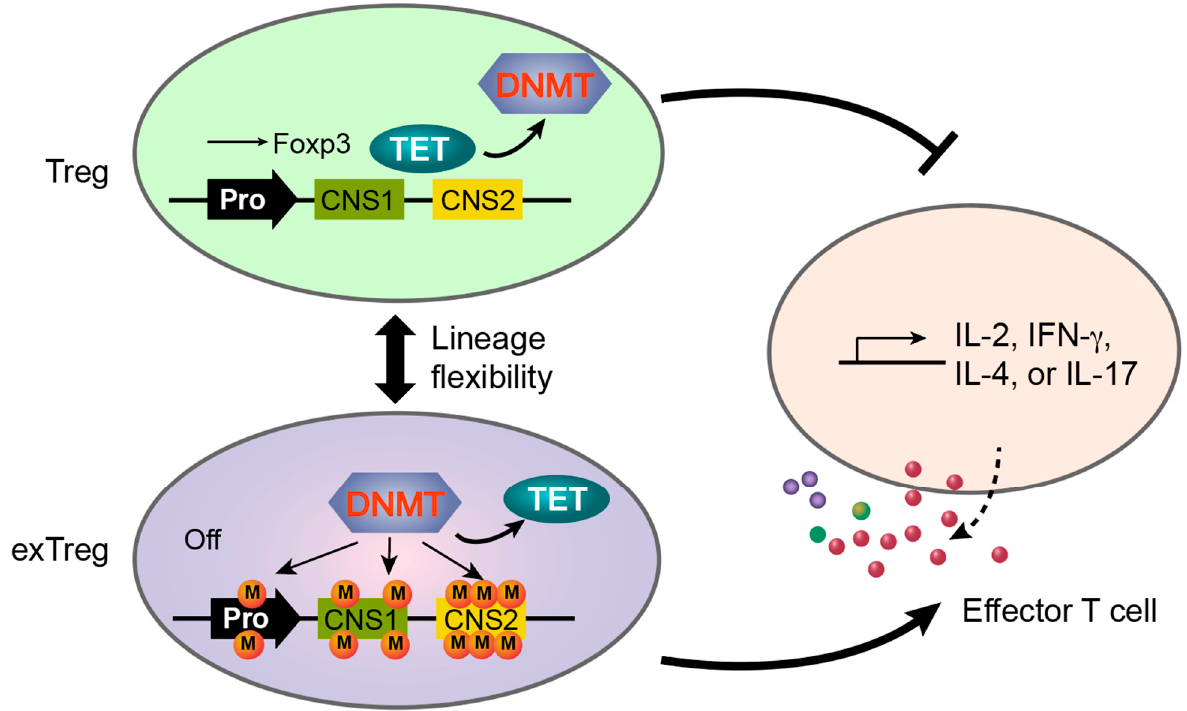
Figure 5. Regulation of Treg cell fate by the competition between DNMT and TET enzymes. A hypothetical model of Treg cell fate maintenance and transdifferentiation. Treg cell fate and suppressive function are maintained by TET enzymes after lineage commitment. In the absence of TET genes or upon stimulation by pro-inflammatory cytokines, DNMT3A/DNMT3B remethylate Foxp3 cis -regulatory elements (e.g., CNS1 and CNS2) and other TSDRs (not shown), leading to the transdifferentiation of Treg cells to effector-like exTreg cells characterized by silenced Foxp3 expression and pro-inflammatory cytokine production. Because DNMT and TET enzymes are targeted by distinct signaling pathways, this dynamic regulation of Treg cell fate and reprogramming fine-tunes immune tolerance accordingly to specific environmental cues likely acting in an antigen-specific manner.